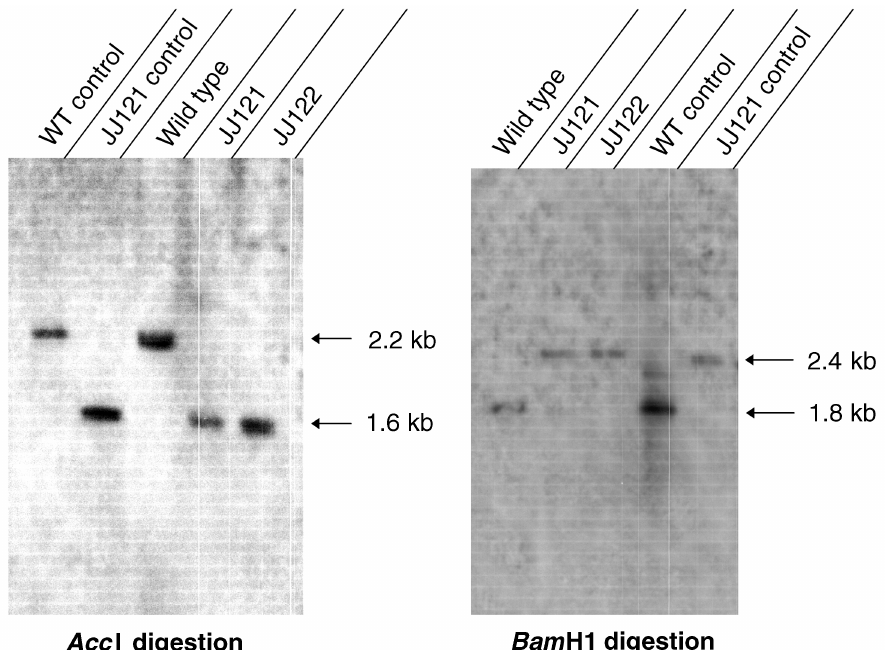
Figure 3. Southern hybridiza- tions of the wild type and Δ cbiJ mutants, JJ121 and JJ122, with a probe to the